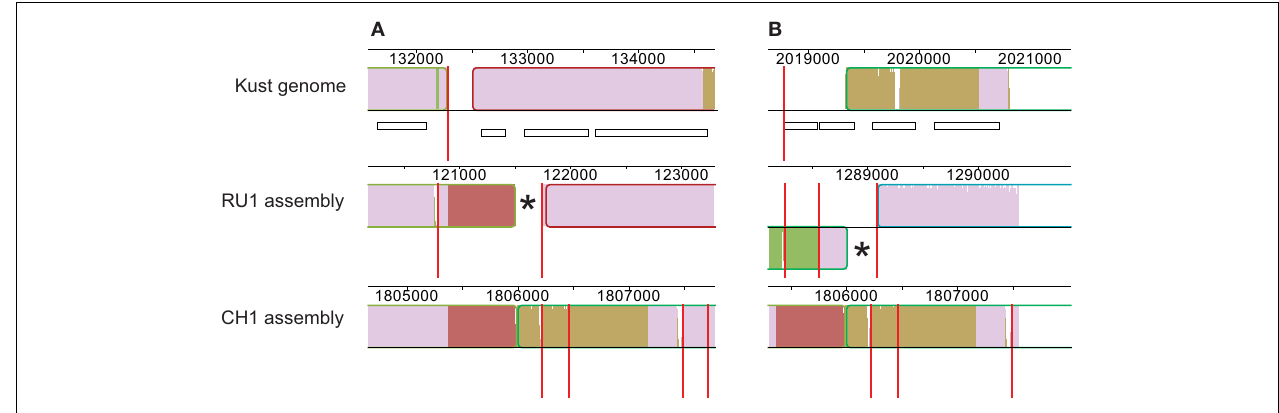
sequence at the start of contig KustE, but not aligned by the Progressive Mauve. (A) Alignment of contigs of RU1 (1699, 1254, 256) and CH1 (1429, 701, 1556, 48) with the terminal sequence of contig KustB. (B) Alignment of contigs of RU1 (262, 334, 2616) and CH1 (1429, 701, 1556, 48) with the start of contig